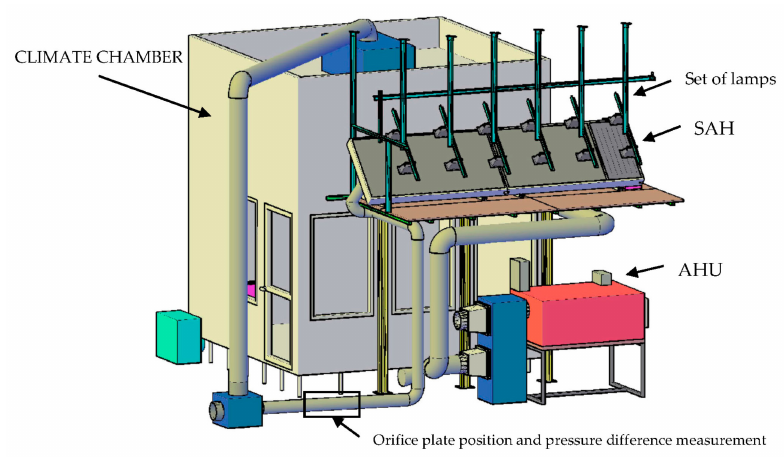
Figure 2. 3D view of the experimental setup.